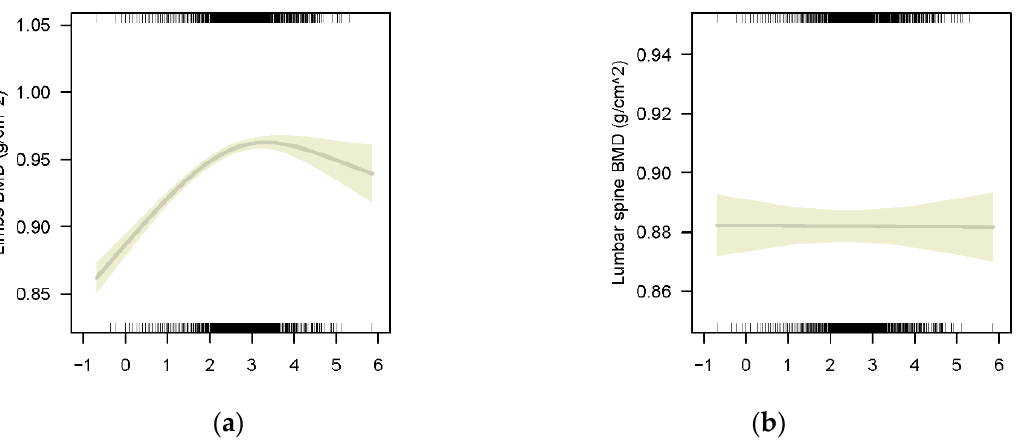
Figure 3. Multivariate models for ln-transformed BLLs on different bony sites’ BMD adjusted for age, sex, race/ethnicity, height, weight, family-income-to-poverty ratio and blood cadmium, with results weighted for sampling strategy: ( a ) Limb BMD, F = 151.9, p = <0.001, R-sq.(adj) = 0.802; ( b ) Lumbar spine BMD, F = 1.554, p = 0.213, R-sq.(adj) = 0.681.